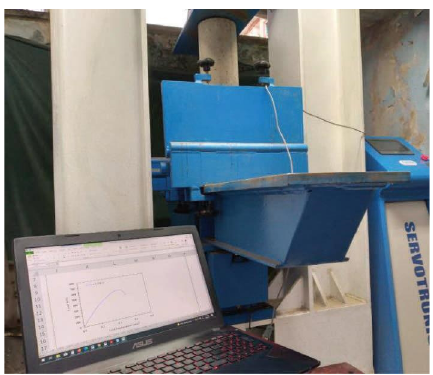
Figure 5: Te loading jack used for the axial compressive strength test of the columns. Table 5: Mixture design (kg/m 3